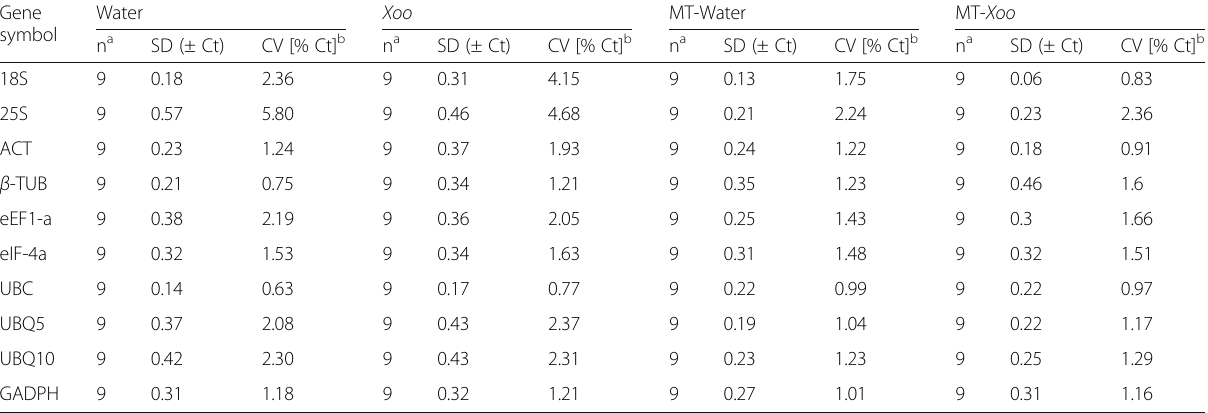
Table 3 Gene expression stability of 10 candidate reference genes calculated by Bestkeeper Gene